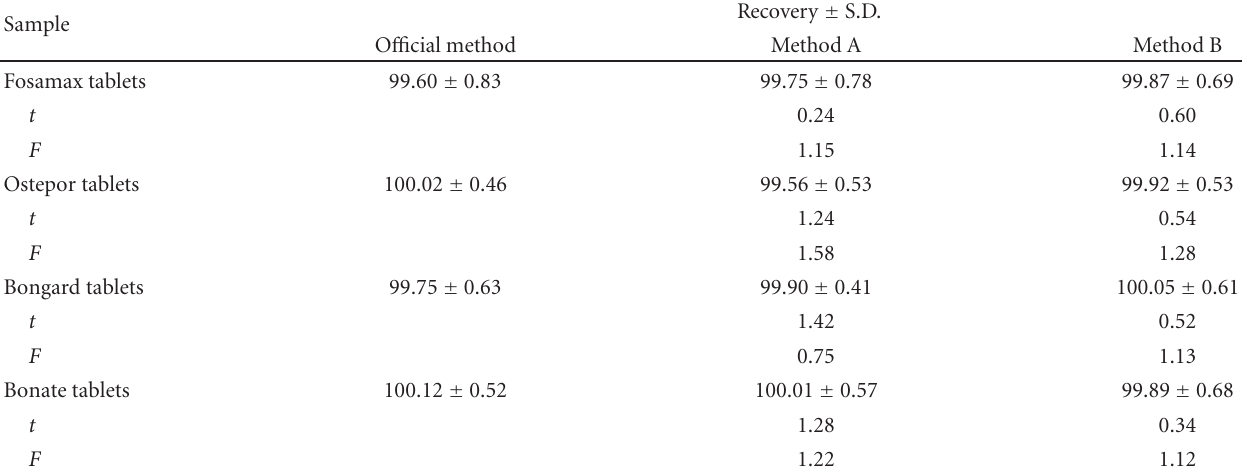
Table 3: Determination of alendronate sodium in pharmaceutical formulations by the proposed and reference [23] methods.